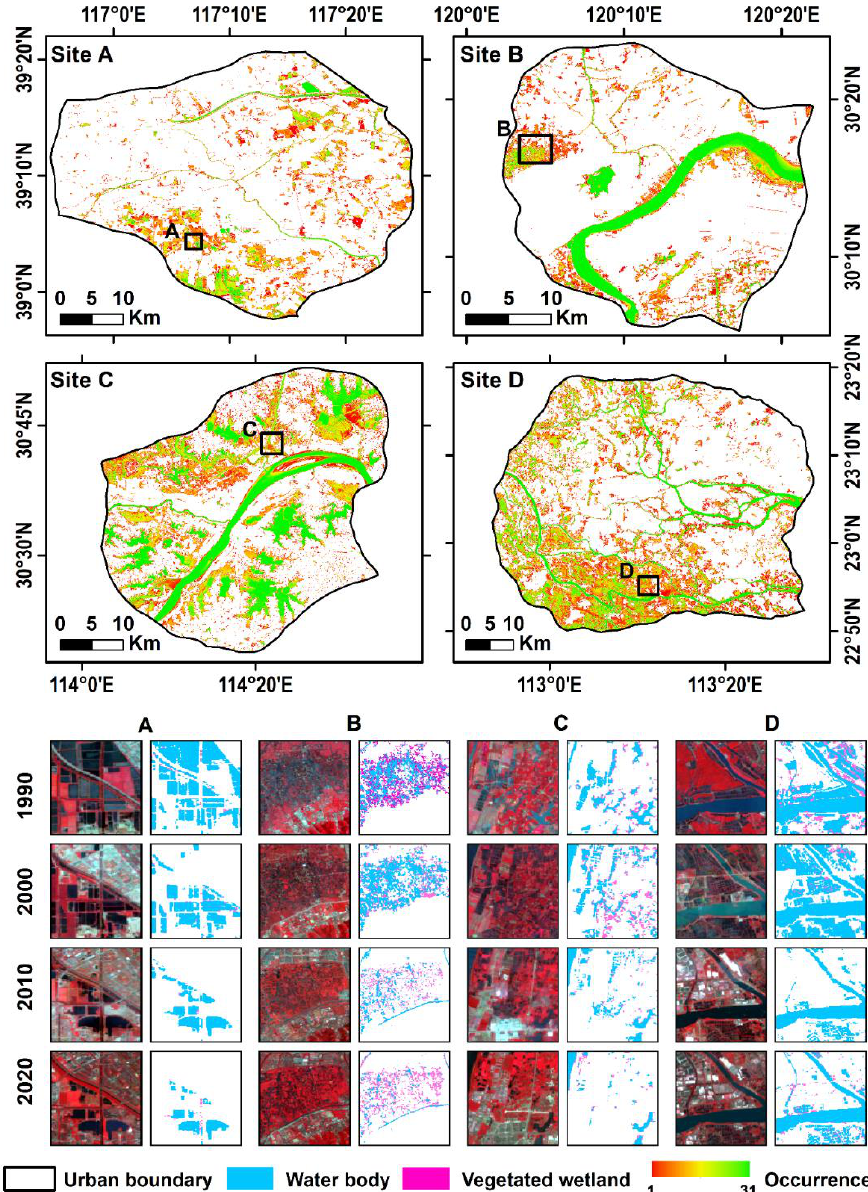
Figure 10. The occurrence map of urban wetlands during the investigated 31 years for each study site (Site(A–D)). The value between 1 and 31 indicates the number of urban wetland occurrences from 1990 to 2020. The subset views ( A – D ) present the detailed changes of urban wetland for each study site with a 10-year interval from 1990 to 2020, respectively. The backgrounds in the views are the Landsat